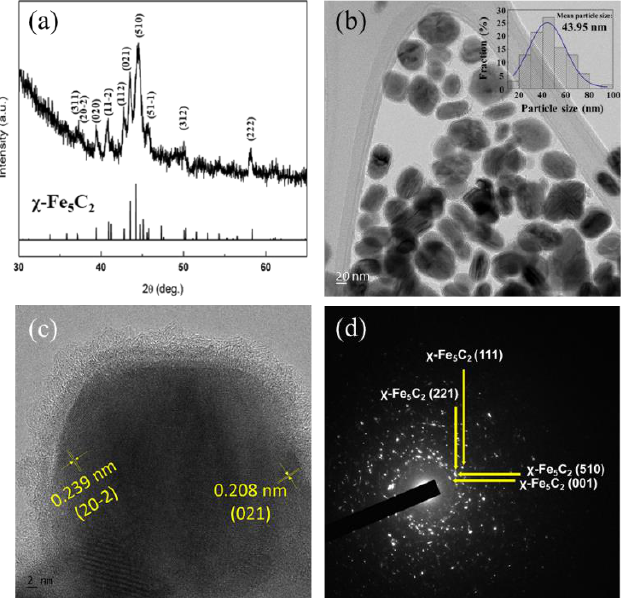
Figure 1. ( a ) XRD pattern; ( b )TEM image; ( c ) HRTEM image; ( d ) SAED pattern of χ -Fe 5 C 2 nanopar- ticles.